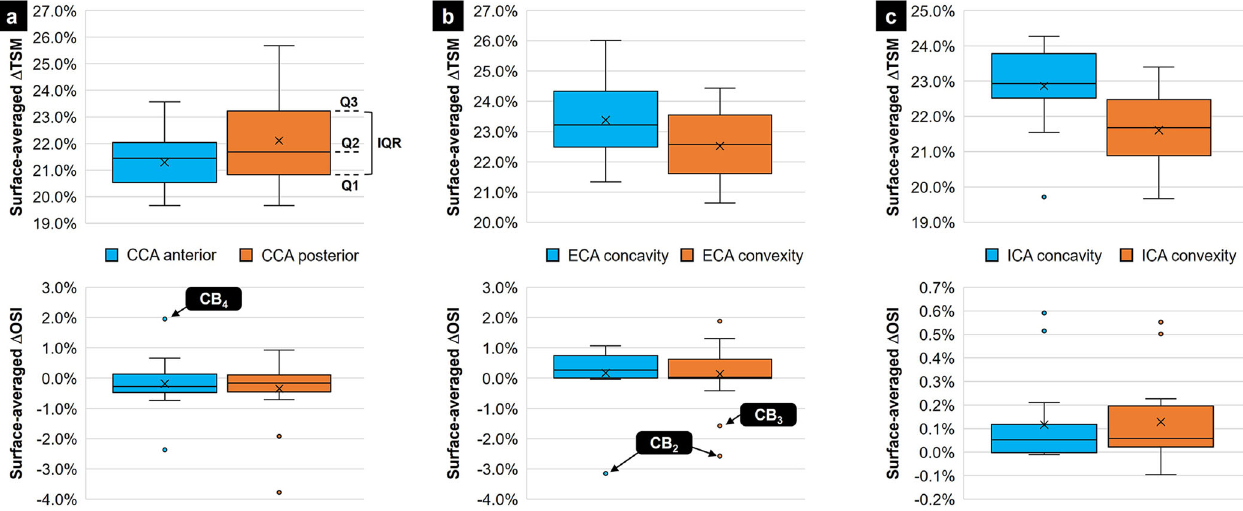
Fig. 5 Box plots showing the analysis of the outlying regional WSS data. Surface-averaged Δ TSM and Δ OSI computed in a the CCA, b the ECA, and c the ICA (Q1: 1st quartile; Q2: 2nd quartile; Q3: 3rd quartile; ×: mean value; top and bottom whiskers: upper and lower limits calculated as Q 3 + 1.5IQR and Q 1 – 1.5IQR, respectively; text in bubble indicates outlying anatomies yielding trends opposite to the population-average with the marginal decrease suggested by the population-average values ( Δ OSI ¼ þ 0 : 16 % in the ECA concavity; Δ OSI ¼ þ 0 : 13 % in the ECA convexity).